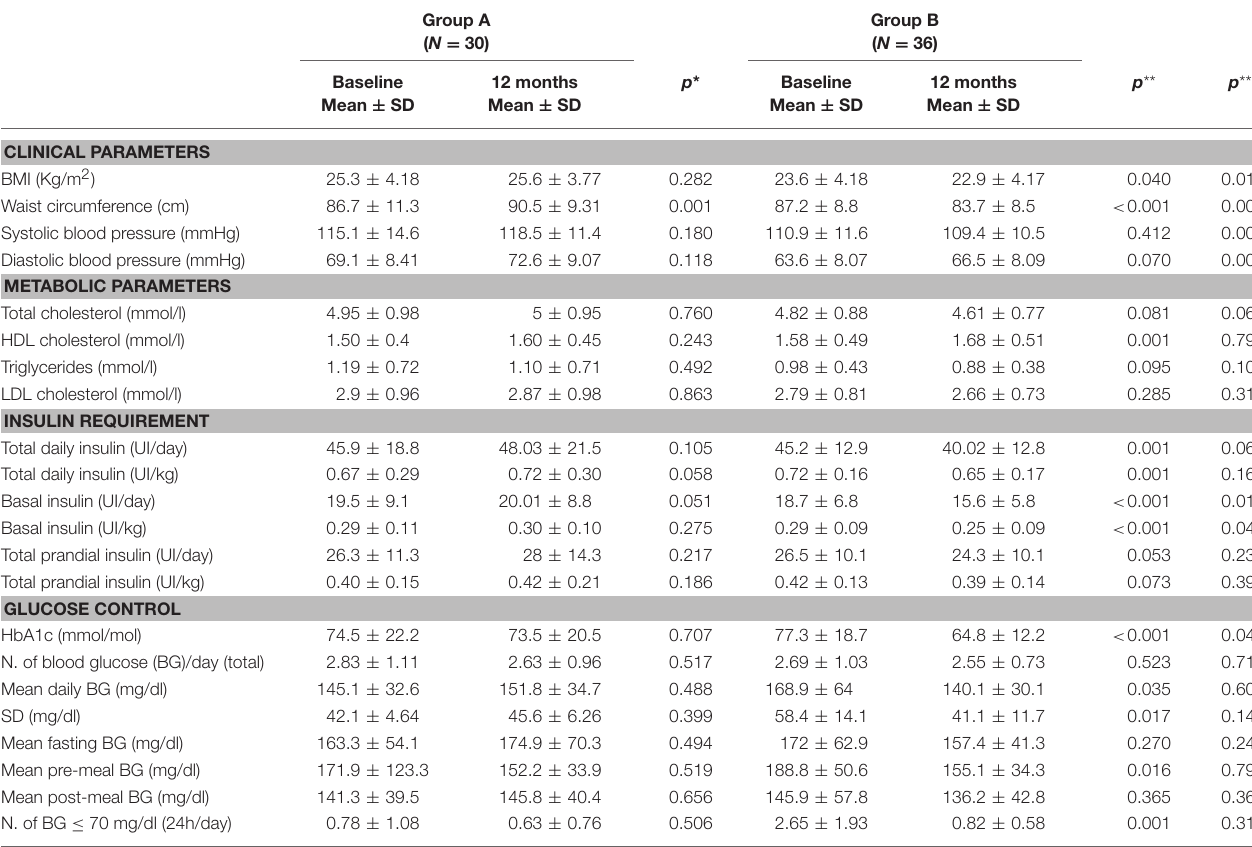
TABLE 2 | Clinical and metabolic parameters, insulin requirement and glucose control in group A and B at baseline and after 12 months of